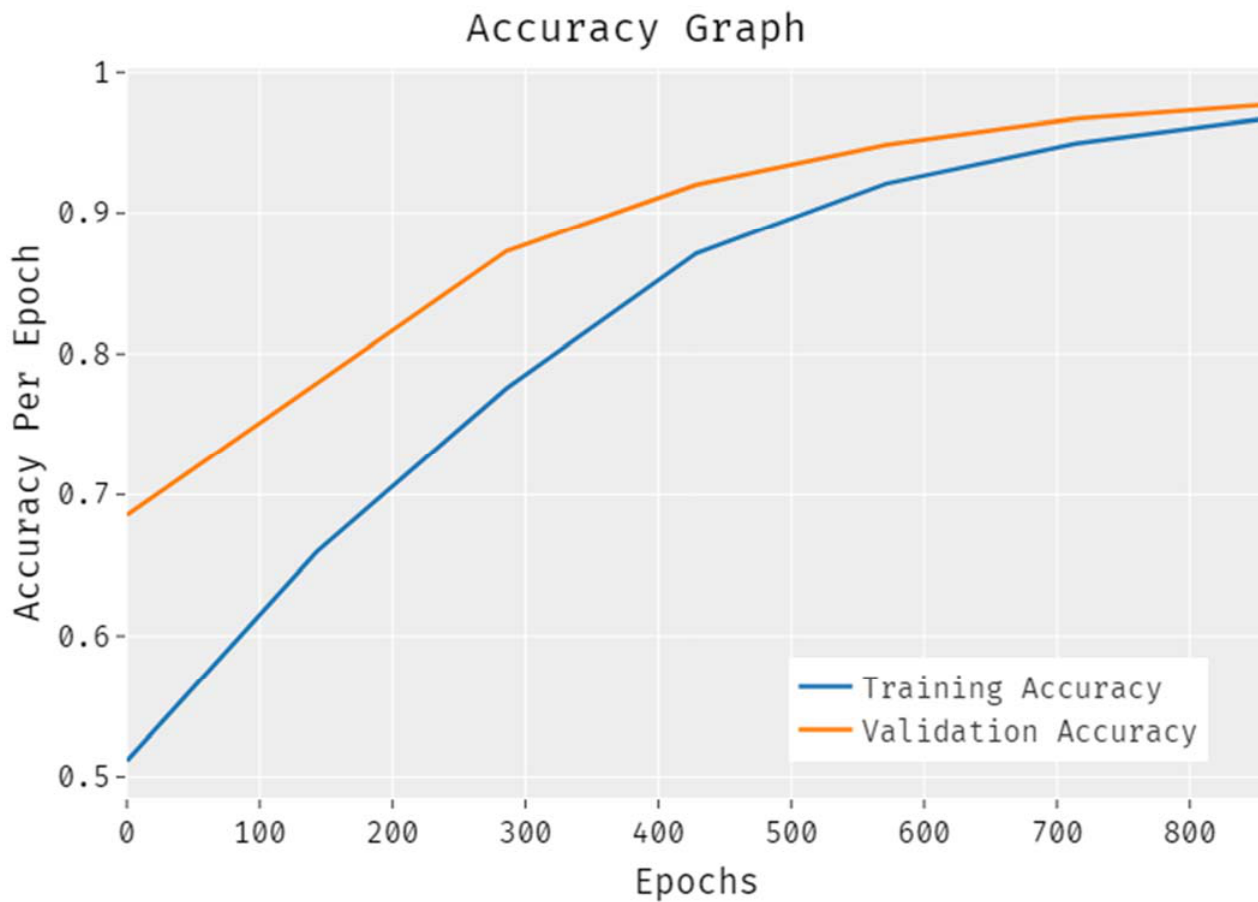
Figure 6. Accuracy analysis results for the EDLCDS ‐ BCDC technique.